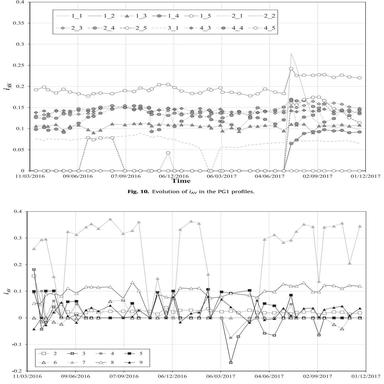
Evolution of iAV in the PG3 profiles.